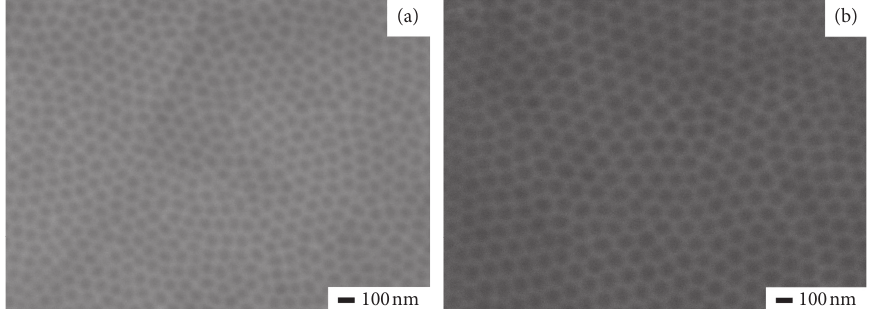
Figure 6: SEM images of stainless steel samples anodized under different stirring: (a) without stirring and (b) with stirring.